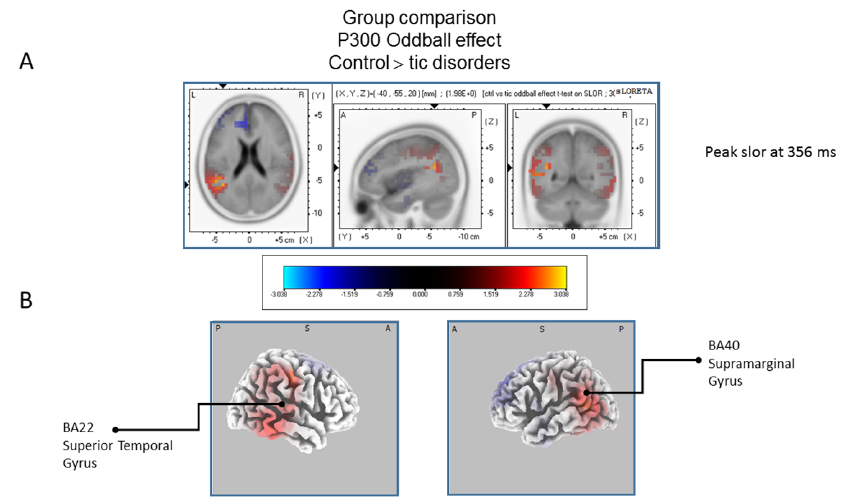
Figure 7. Results of the tic disorder patients based on the standardized low-resolution brain electrotomography (sLORETA) current source density localization of the oddball effect (contrast:“Ctrl” > “Tic”) in the mean activation of the P300 component within a 300–550 ms time window. Images have been obtained after statistical non-parametric mapping (SnPM) and co-registration to the stereotaxic Talairach space based on the Co-Planar Stereotaxic Atlas of the Human Brain [83] and the probabilistic MNI-152 template [81]. There is no significant activated voxels (after correction for multiple comparisons ( p < 0.05)). ( A ) Although non-significant, the peak of highest cortical activity has been found in parts of the temporal gyrus (BA22), supramarginal gyrus (BA40). ( B ) A shifted transverse and sagittal view of the left and the right hemisphere, showing cortical activations on the three-dimensionally rendered Colin27 template [89]. A, anterior; P, posterior; MNI, Montreal Neurological Institute; X, Y, Z, corresponding MNI coordinates; BA, Brodmann area.